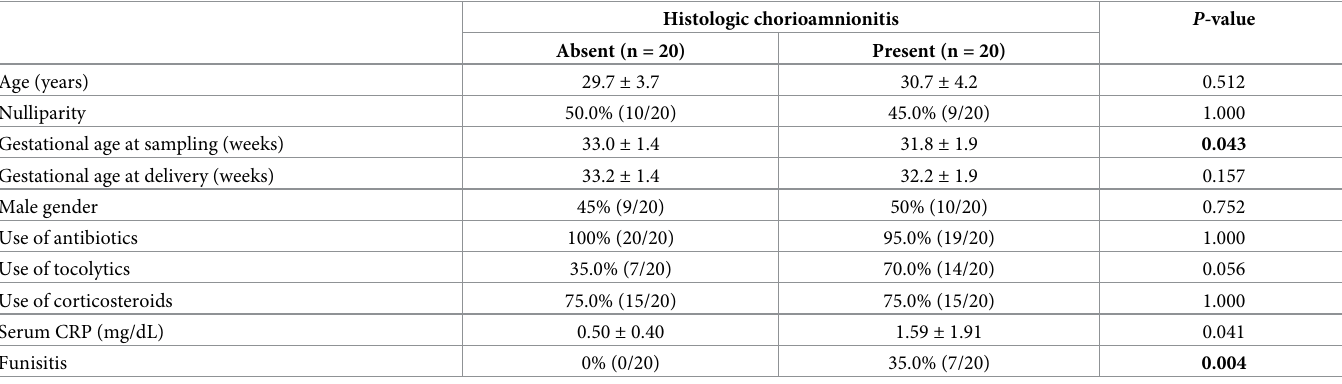
Table 2. Demographic and clinical characteristics of women with preterm premature rupture of membranes included in the MRM verification